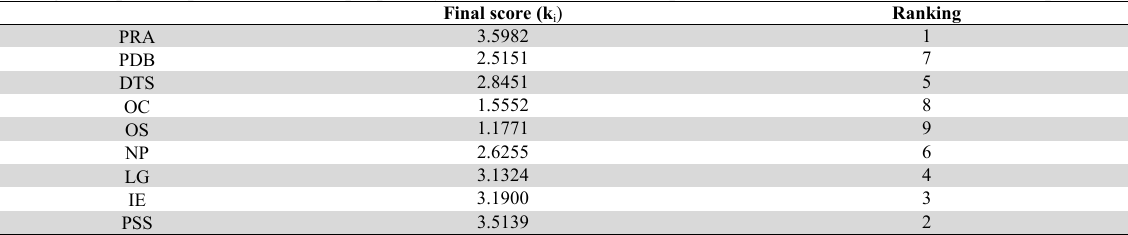
Ranking of expert’s opinion on user’s propensity to use, diffuse, and adopt HLDBE for their future sustainable